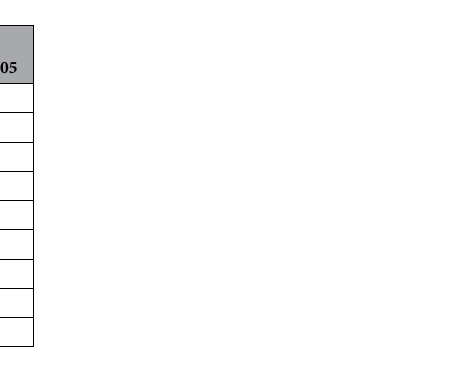
Table 5. Comparison of results (accuracies in %) obtained by the different optimization algorithms (OAs) for feature selection (FS) in our DSwarm-Net model and that obtained without any FS, by end-to-end CNN